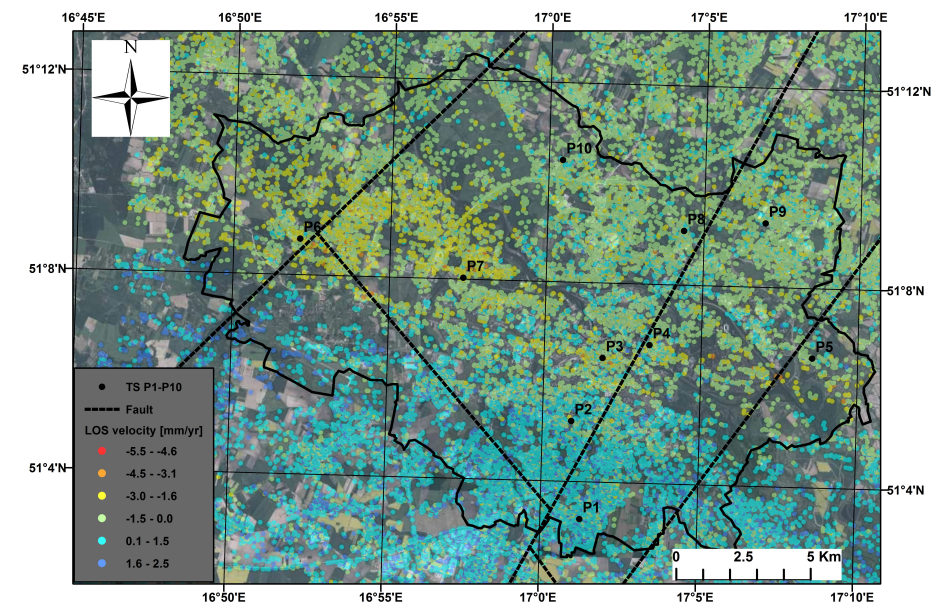
Figure 8. LOS velocities determined on the basis of Sentinel-1A data for the period